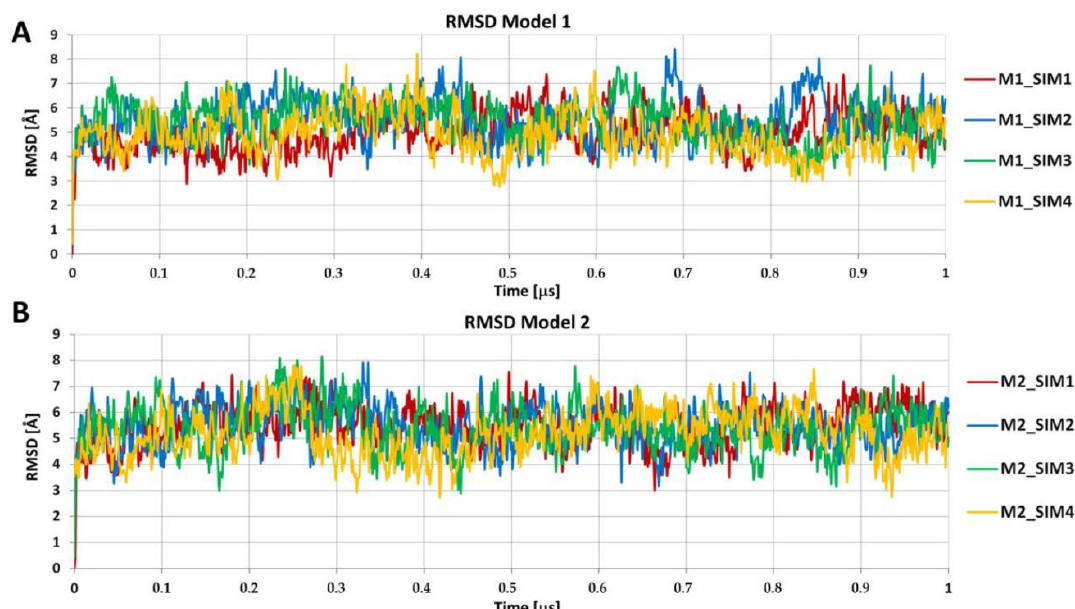
Figure 3. Plots showing the RMSD values for C-alpha atoms of amyloid fibrils calculated during AA MD simulations lasting 1 µ s. For each of the two amyloid fibril models (model 1—panel ( A ), and model 2—panel ( B )), 4 independent MD simulations were conducted using random starting velocities.